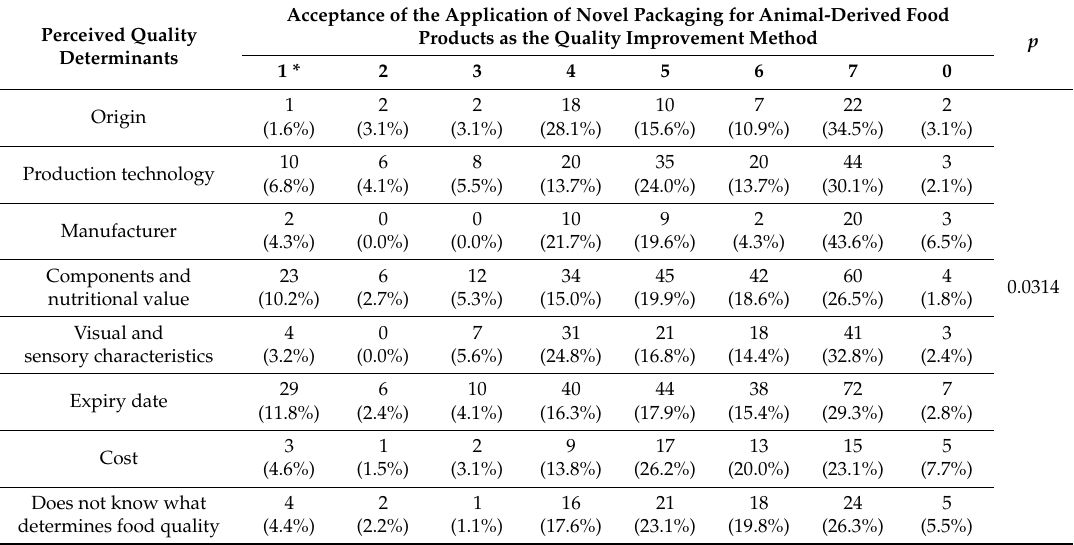
Table 5. Level of acceptance of novel packaging in animal-derived food products for respondents stratified by perceived quality